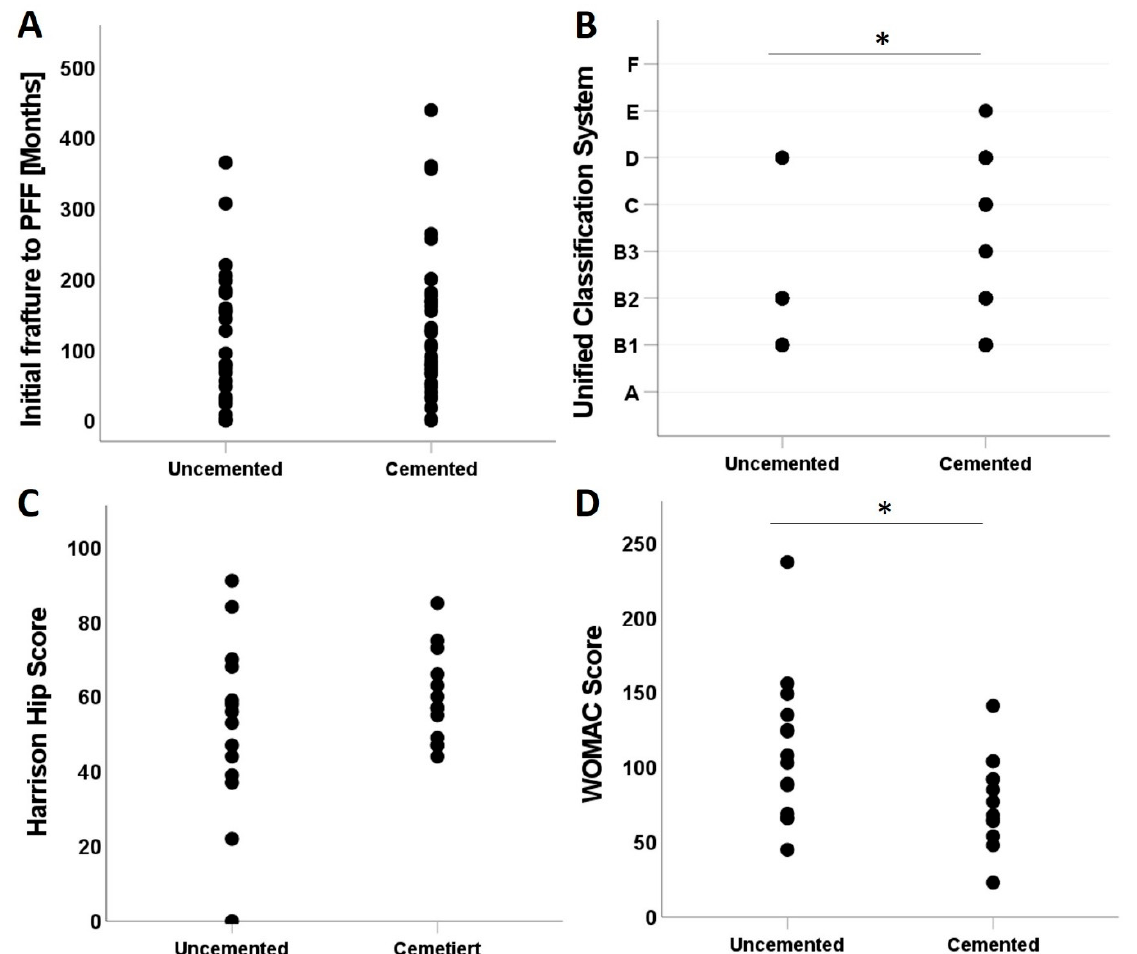
Figure A1. Impact of cementation on ( A ) initial time between initial fracture to PFF, ( B ) UCS severity, ( C ) the Harris Hip score, and ( D ) the WOMAC score. *: p -Value <=